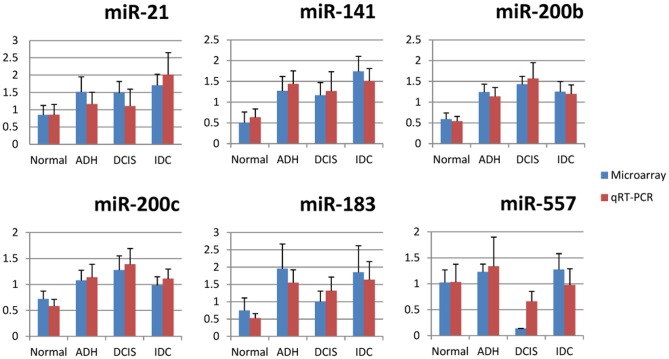
QRT-PCR verification of miRNAs expression results from microarray data.Blue bars represent the results from microarray, while red bars indicate the results from qRT-PCR. The error bars are the standard error of mean (SEM) for each analysis. QRT-PCR results are largely consistent with our microarray data. Five representative miRNAs (miR-21, miR-183, miR-141, and miR-200b/c) were observed up-regulated during the Normal-ADH transition, and their high expression levels were maintained throughout the tumor developmental stages. miR-557 was found to be down-regulated specifically in the DCIS stage.